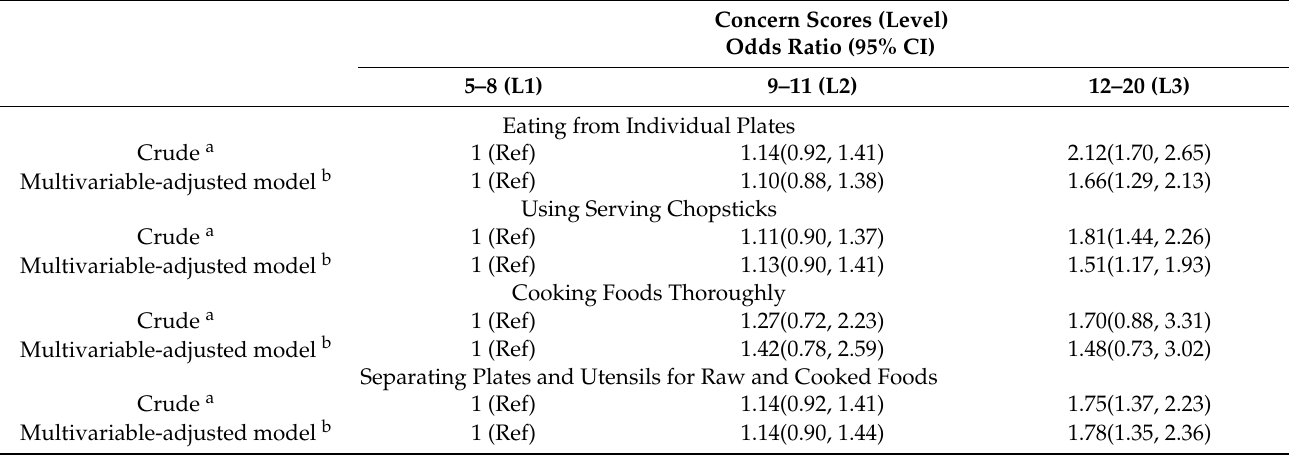
Table 3. Associations between Food, Nutrition, and Health Related Concerns Regarding Eating and Cooking